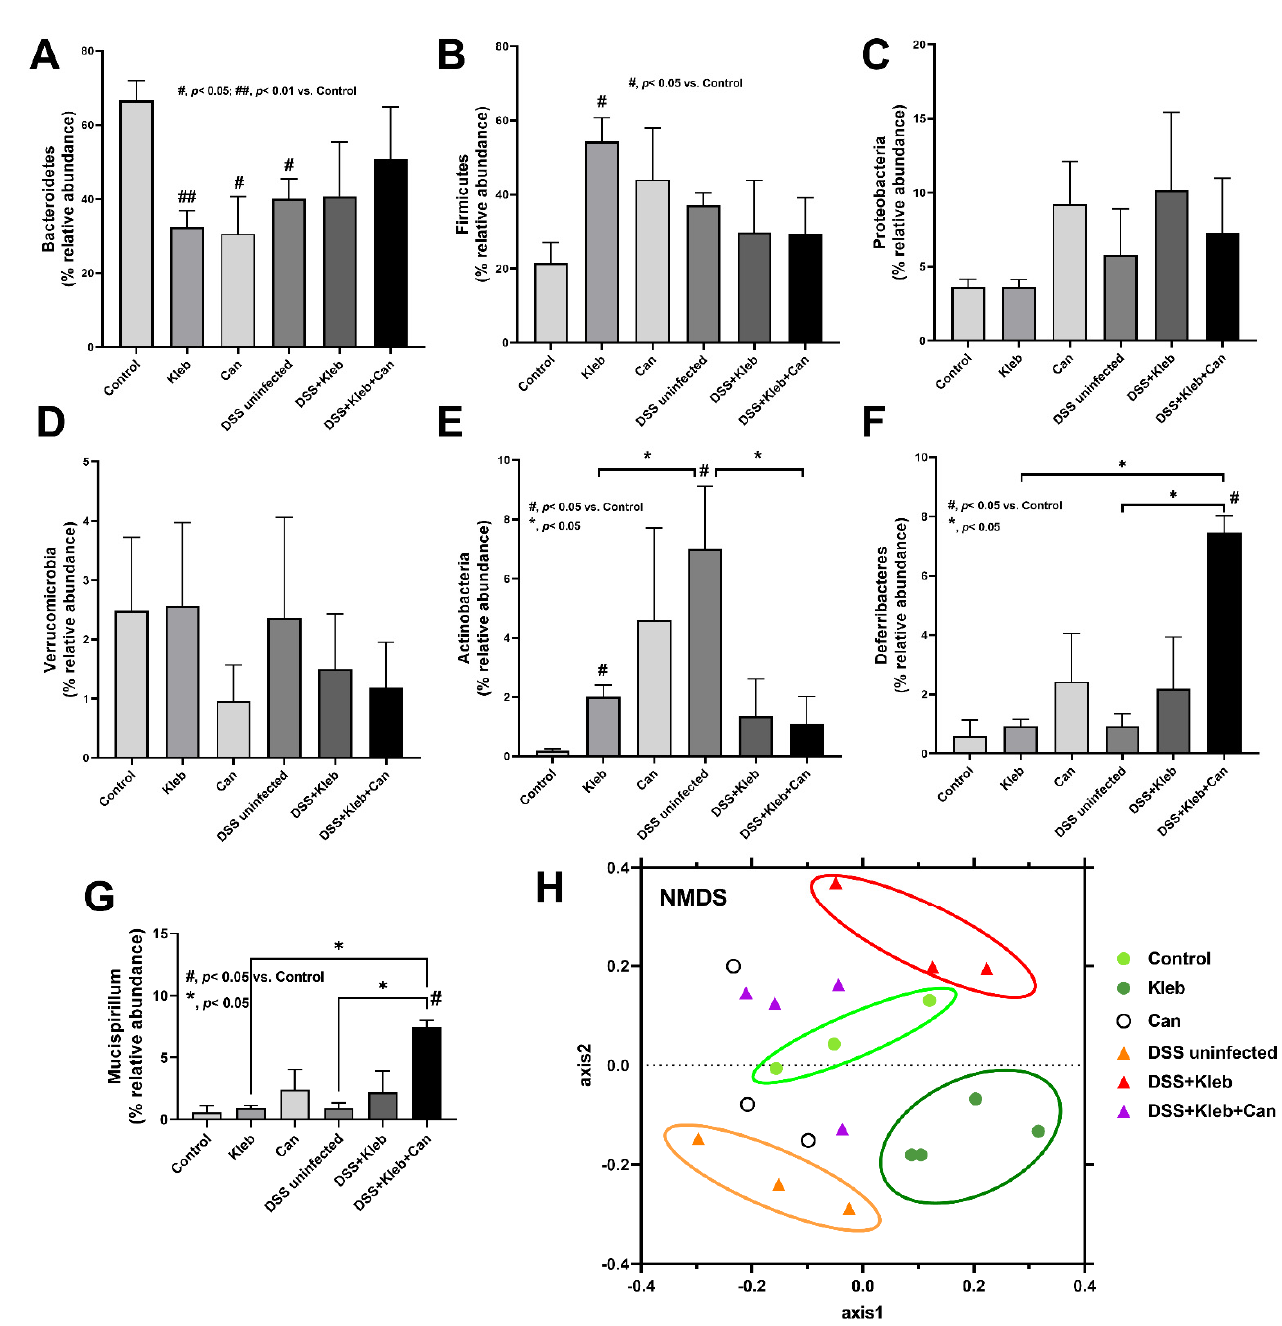
Figure 5. The characteristics of mice after daily gavage with phosphate buffer solution (control), K. pneumoniae (Kleb) , or C. albicans (Can) with or without dextran sulfate solution (DSS) as indicated by the graph presentation of the abundance of fecal bacteria in some phylum and genus ( A – G ) with the Non-Metric Multidimensional Scaling (NMDS) analysis ( H ). (n = 3–4/group). *, p < 0.05; #, p < 0.05; ##, p < 0.01 vs. control, the indicated groups as have determined by ANOVA with Tukey’s analysis.